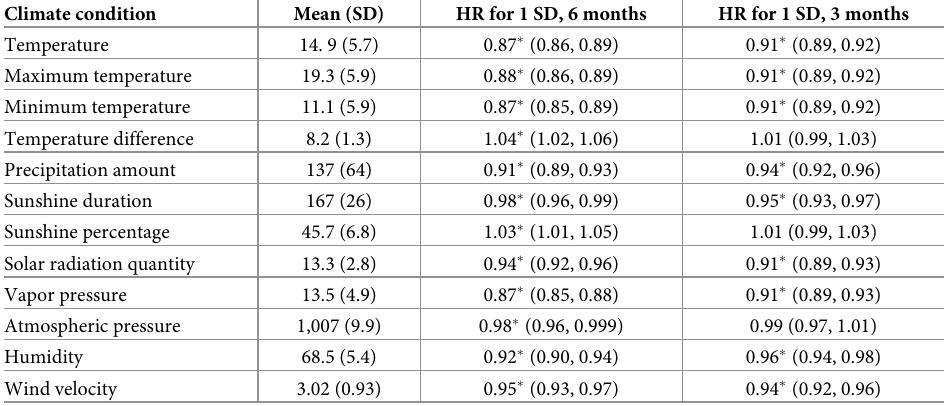
Table 1. HRs (95% confidence intervals) of the incidence of atopic dermatitis for a one standard deviation increase in the mean climate condition from birth to 3 or 6